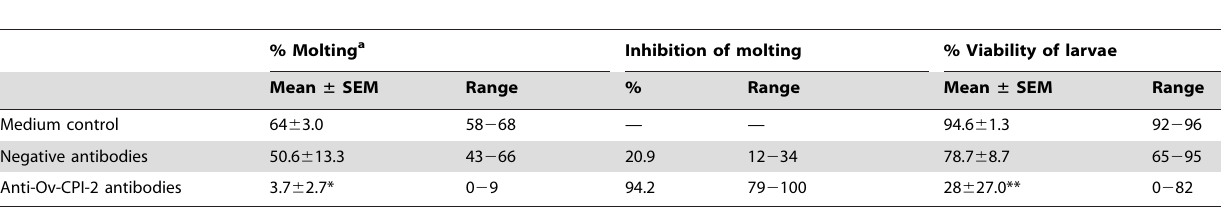
Table 3. Effect of mono-specific human anti- Ov -CPI-2 antibodies on L3 molting and viability in the presence of normal human